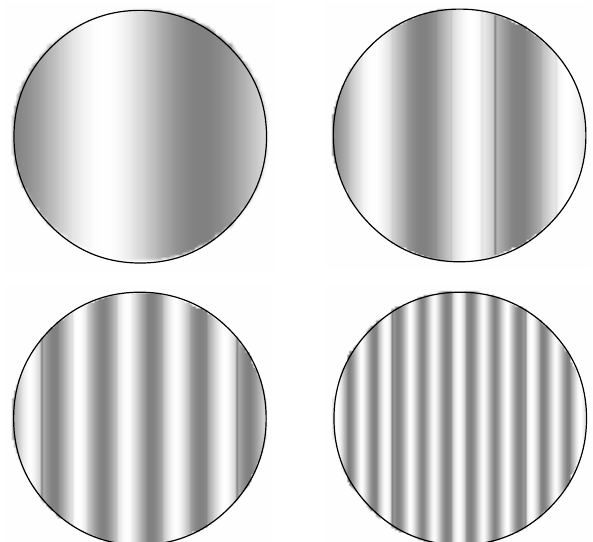
Figura 1 . Exemplos de estímulos de freqüências espaciais (acima, da esquerda para a direita, 0,25 e 0,5 cpg e embaixo, da esquerda para direita, 1 e 2 cpg). Estímulos originalmente calibrados para serem vistos a 150 cm de